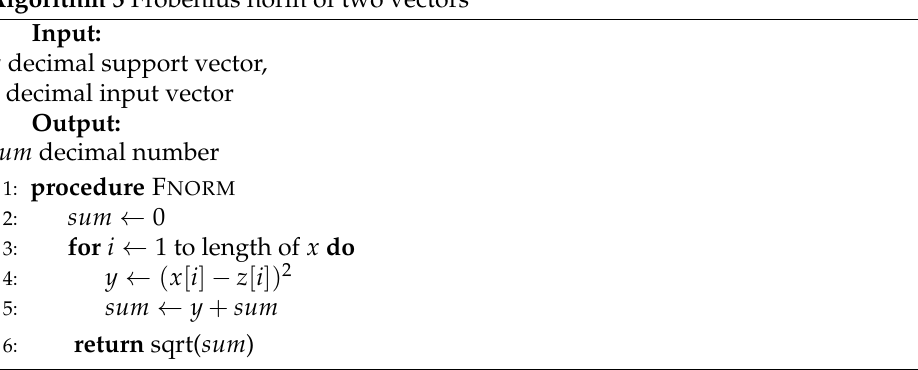
Algorithm 5 Frobenius norm of two vectors